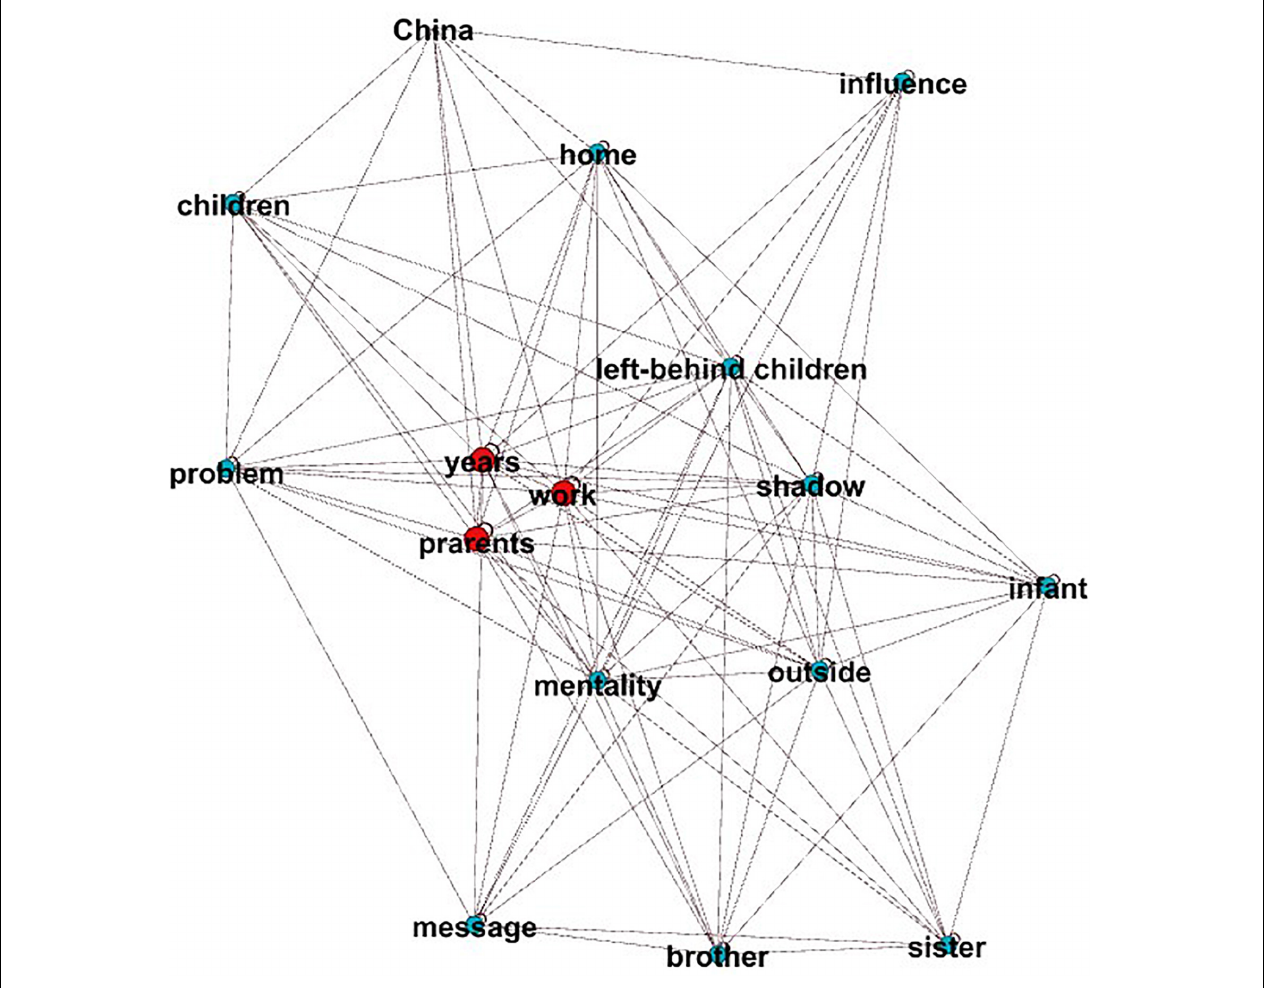
FIGURE 7 | Low-level